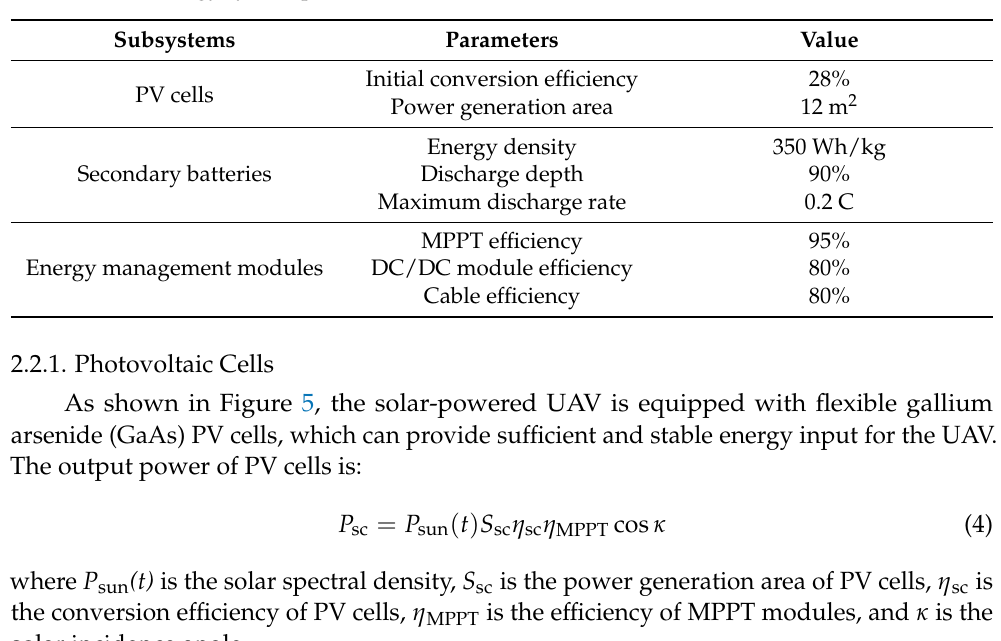
Table 3. Main energy system